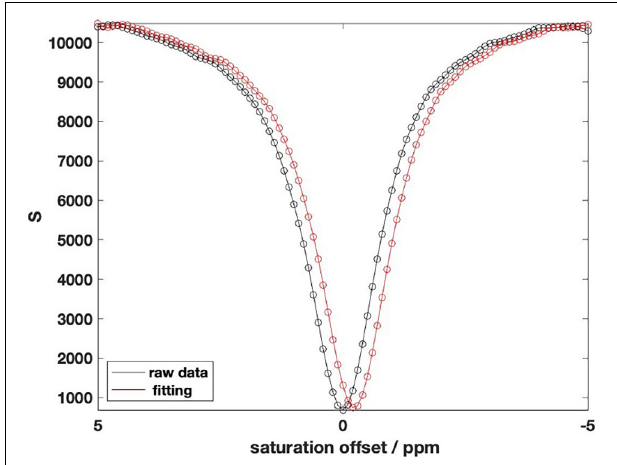
FIGURE 2 | Chemical exchange saturation transfer (CEST) data after WASSR correction.